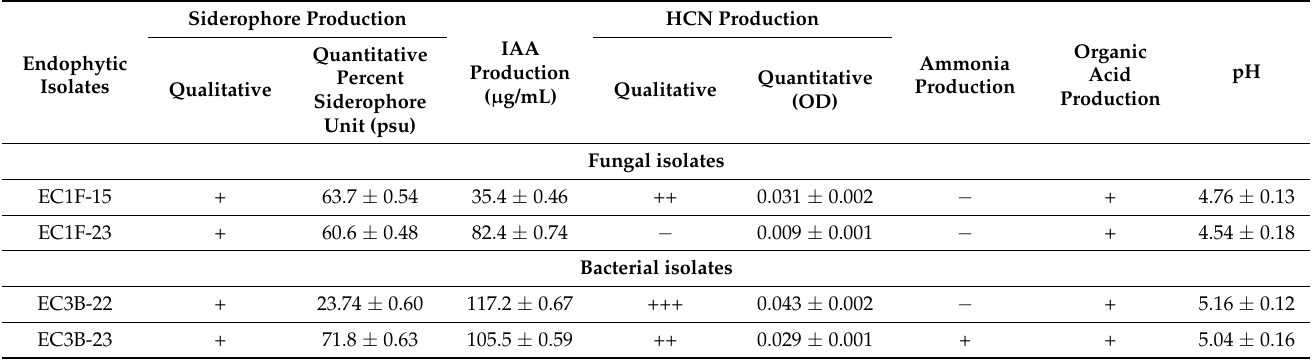
Table 2. Siderophore, IAA, HCN, ammonia, and organic acid production by endophytes. The pH was measured at the time of organic acid